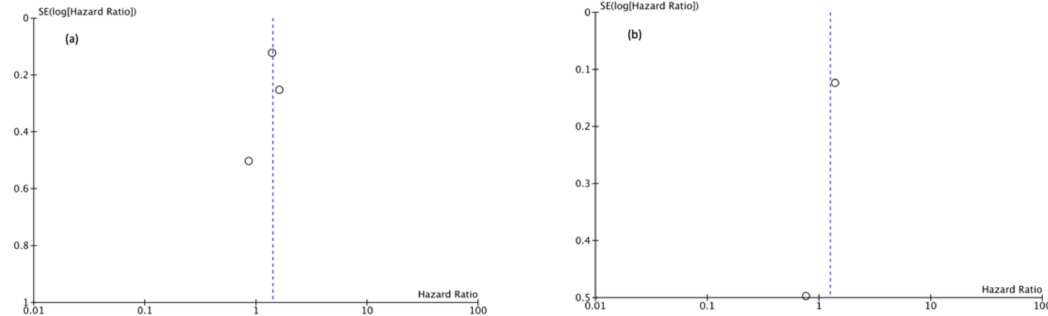
Figure 9. ( a ) Funnel Plot PFS 5y, ( b ) Funnel Plot PFS